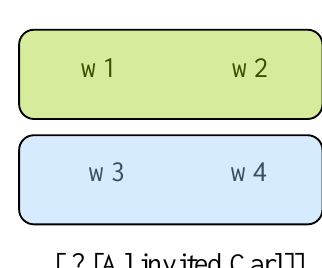
Figure 1. Denotation of (23) Figure 2 . Denotation of